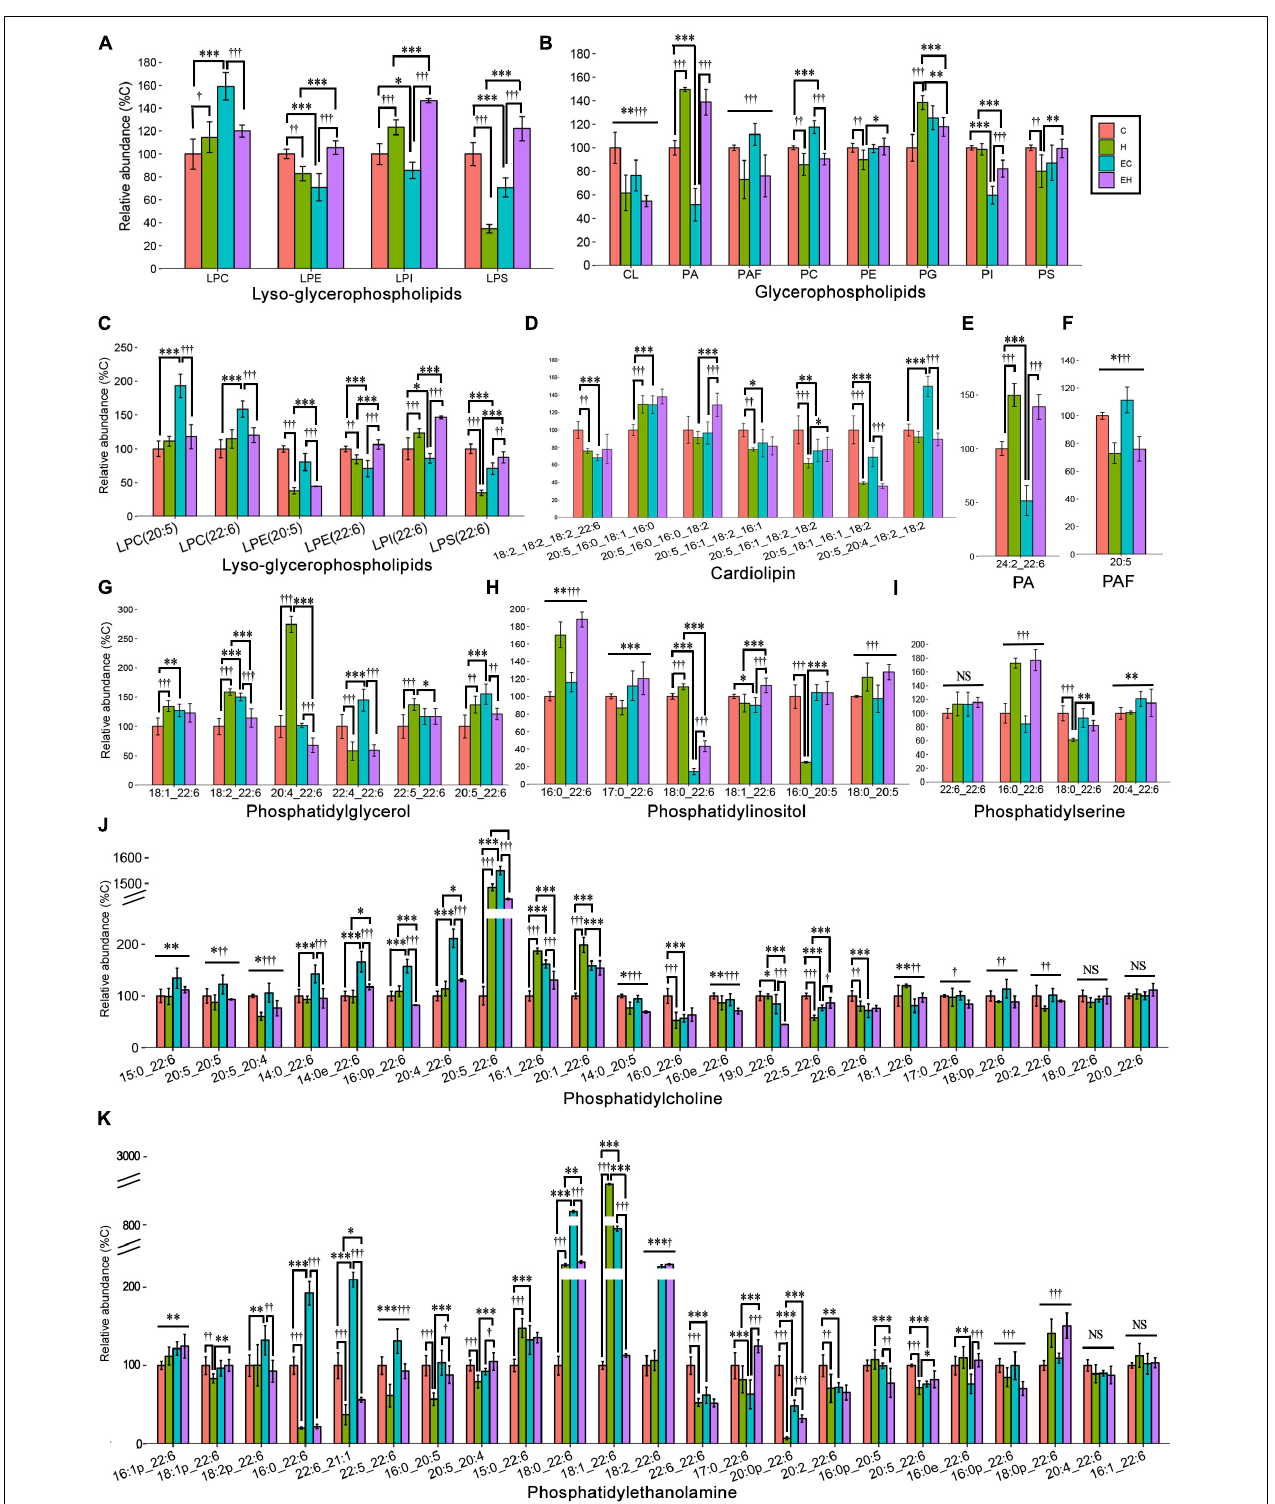
FIGURE 6 | Lipidomic analysis of ω -3 PUFA-Glycerophospholipid classes (A,B) and the individual molecular species (C–K) in skeletal muscle: PA, phosphatidic acid; PAF, platelet-activating factor; ∗ p < 0.05 for endurance training effect; ∗∗ p < 0.01 for endurance training effect; ∗∗∗ p < 0.001 for endurance training effect; † p < 0.05 for high-fat diet effect; †† p < 0.01 for high-fat diet effect; ††† p < 0.001 for high-fat diet effect; straight lines represent the main effect of endurance training or high-fat diet; lines with sticks represent an interaction effect exists between endurance training and high-fat diet. Data are means ± SD.